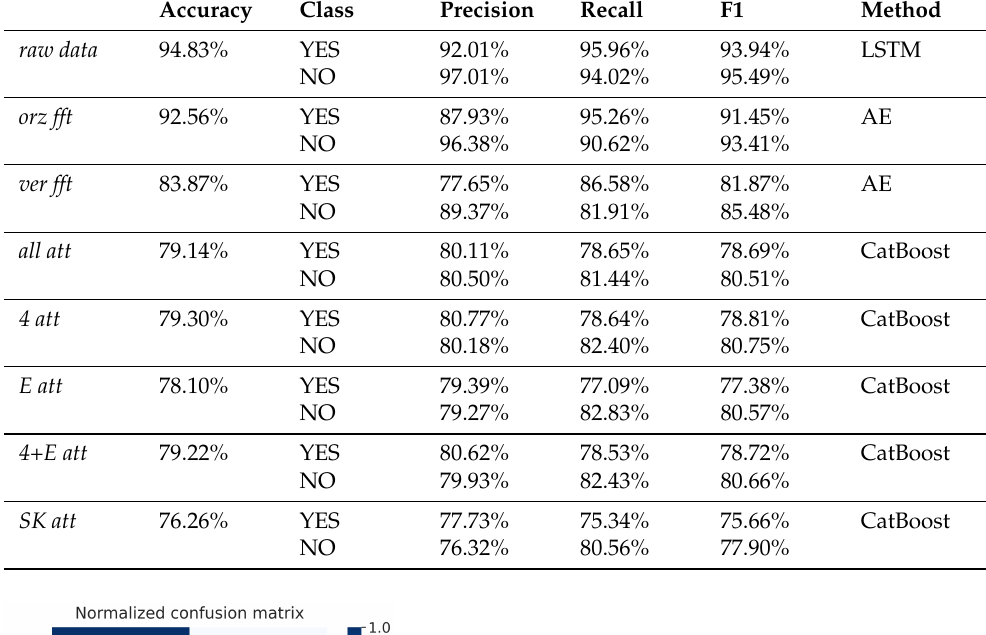
Table 5. Supervised methods—dynamic case.